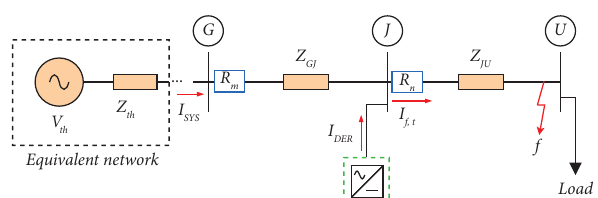
Figure 4: ADN in normal operating condition (no fault) and faulted operating